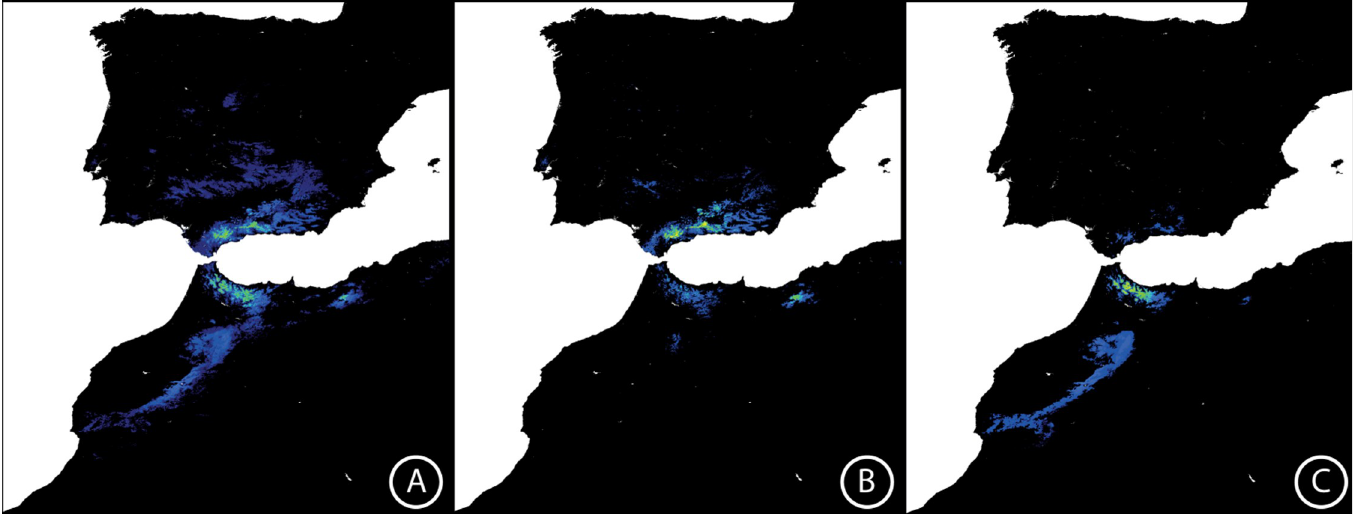
Fig 5. MaxEnt distribution map showing the environmental suitabilty for Cynara baetica for the present time. (A) C . baetica s.l., (B) C . baetica subsp. baetica , and (C) C . baetica subsp. maroccana (C). Warmer colors depict higher environmental